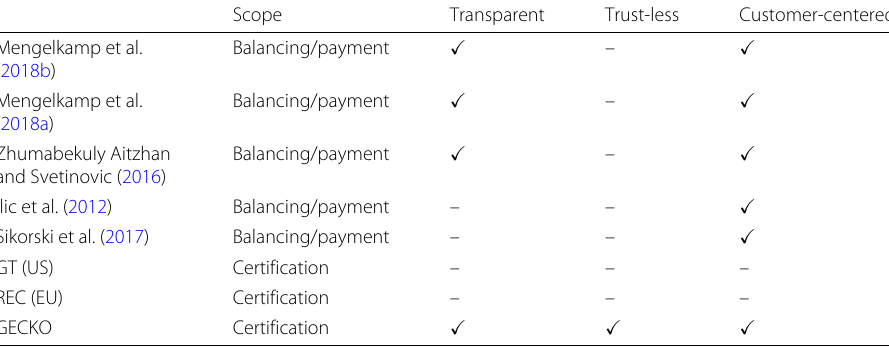
Table 1 Comparison of related